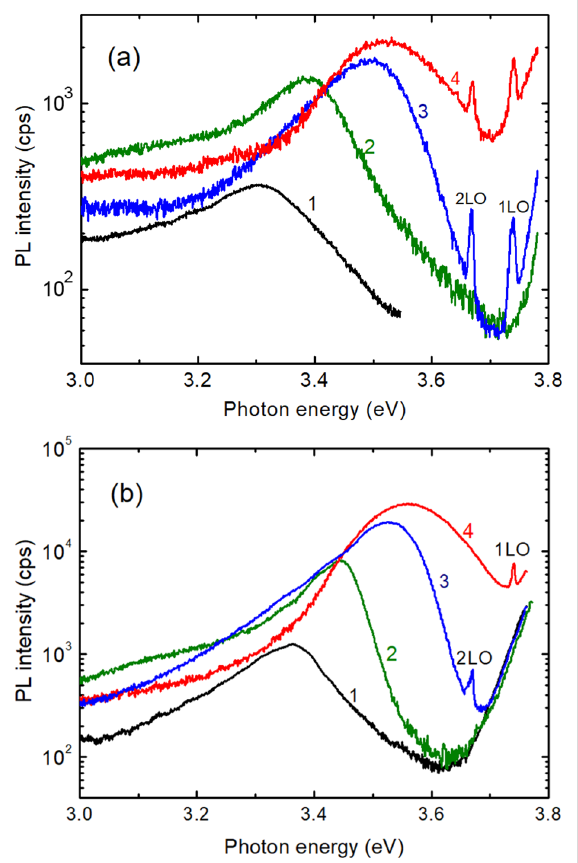
Figure 4: PL spectra of Zn 1 − x Mg x O films deposited by spin coating with x values of 0.00 (1); 0.05 (2); 0.15 (3); and 0.40 (4), annealed at 500 °C and measured at a) 300 K and b) 20 K.